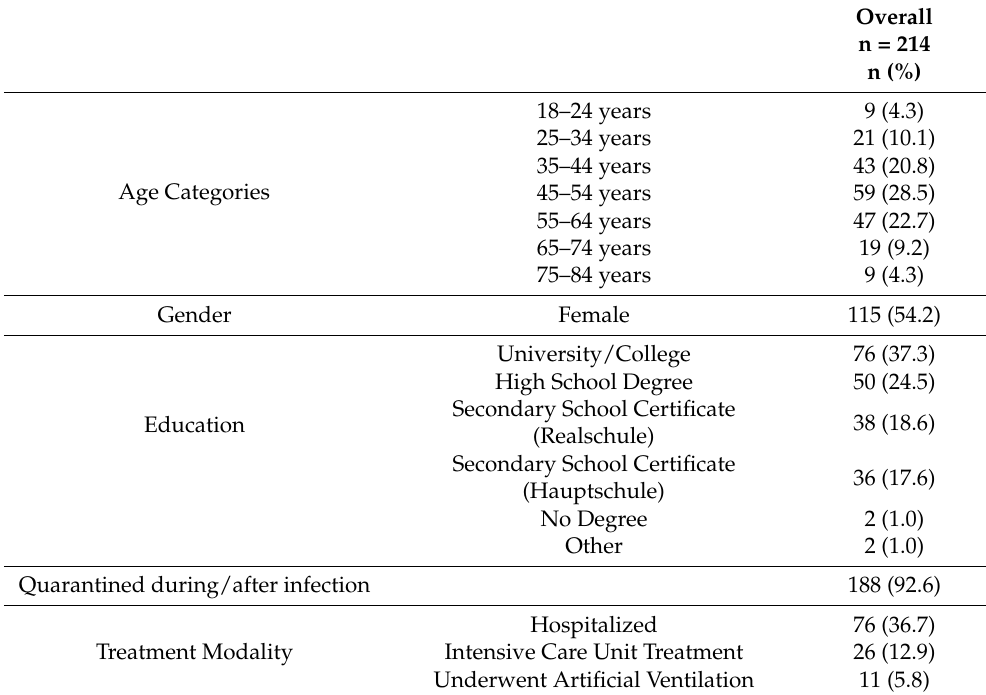
Table 1. Demographics. Values are presented as n